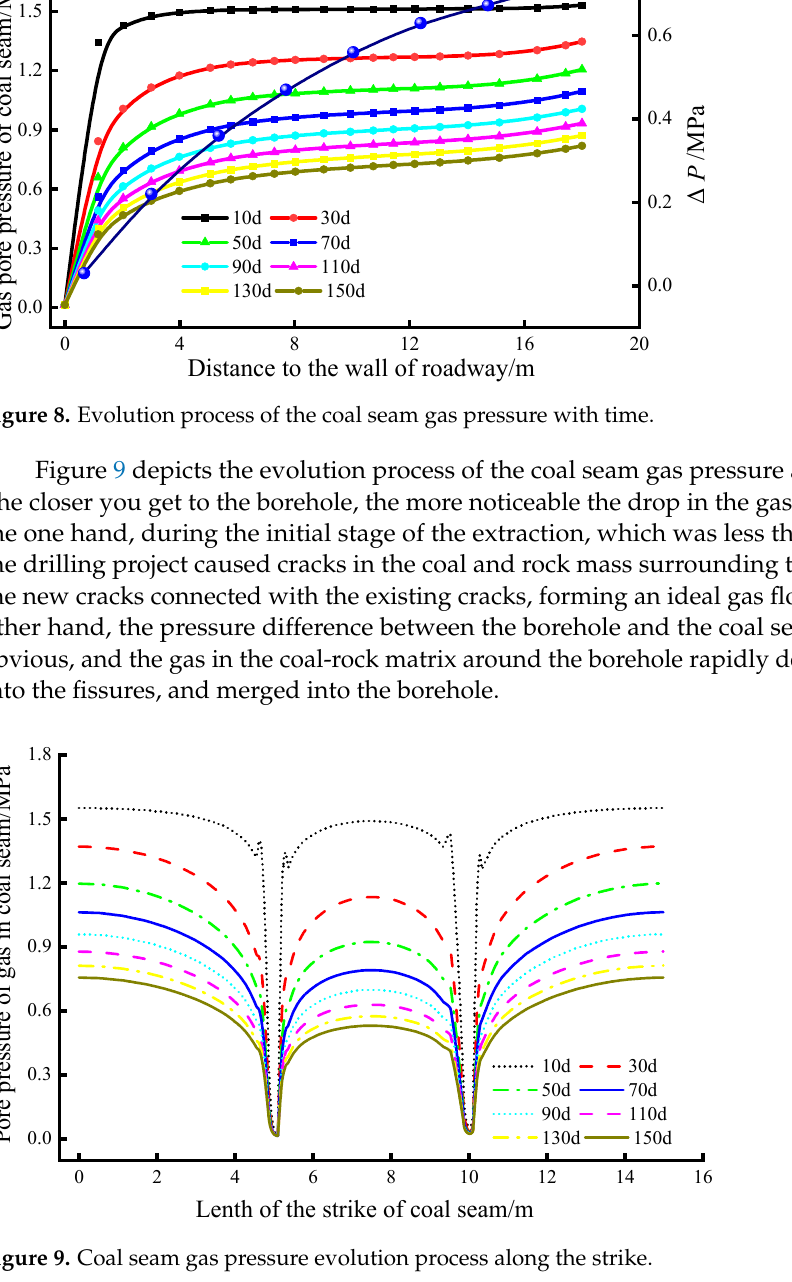
Lenth of the strike of coal seam/m Figure 9. Coal seam gas pressure evolution process along the strike. Figure 9. Coal seam gas pressure evolution process along the strike. Figure 9. Coal seam gas pressure evolution process along the strike. As the extraction time increased, the pressure difference between the borehole and the coal-rock fractures around the borehole reduced, weakening the negative